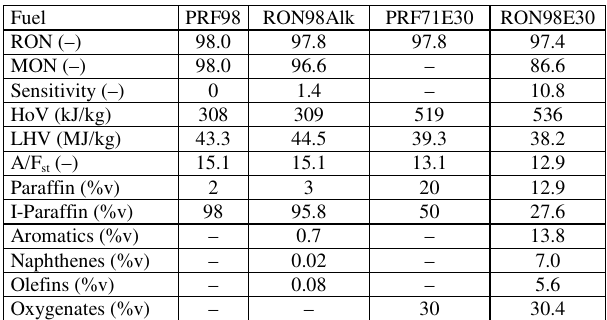
Table 5. Properties of test fuels